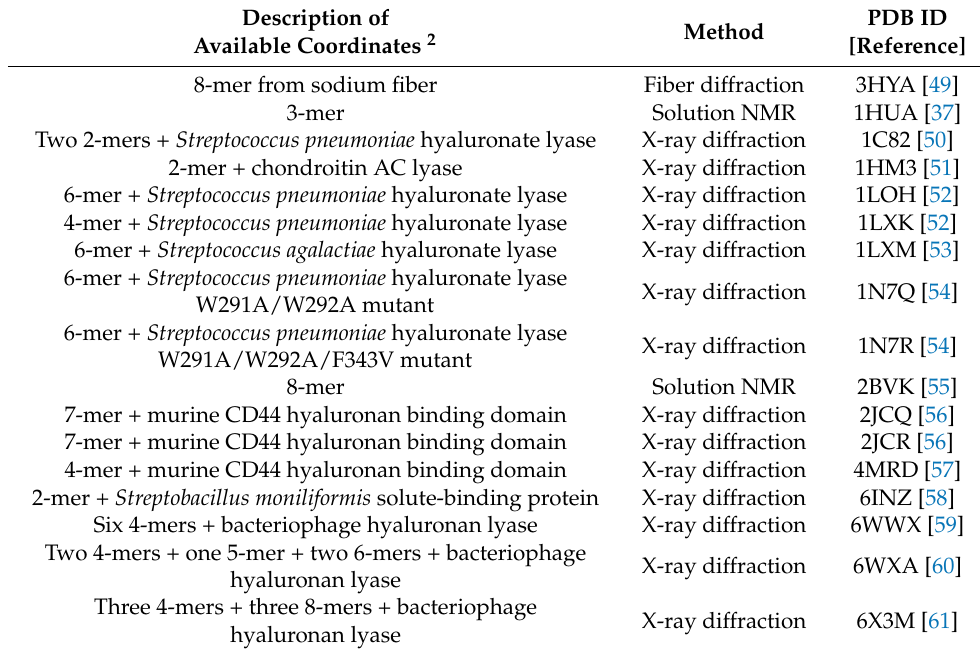
Table 1. Complete list of PDB entries containing hyaluronan 1